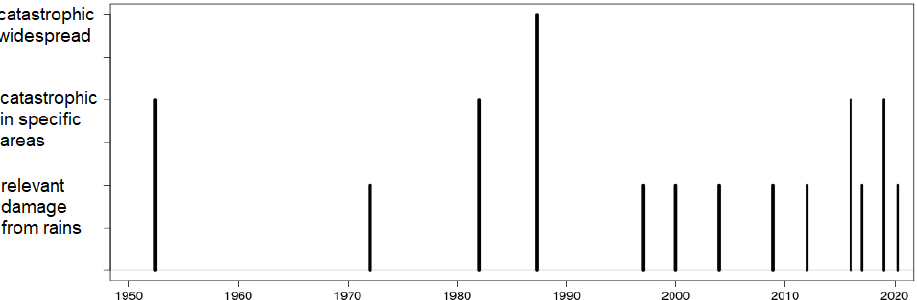
Figure 1. Impact level of flooding events between 1950 and 2020 in the Region of Murcia. Source: Consorcio de Compensación de seguros de España [22].